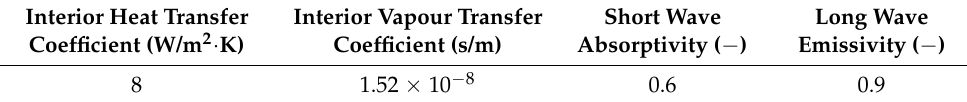
Table 2. Boundary